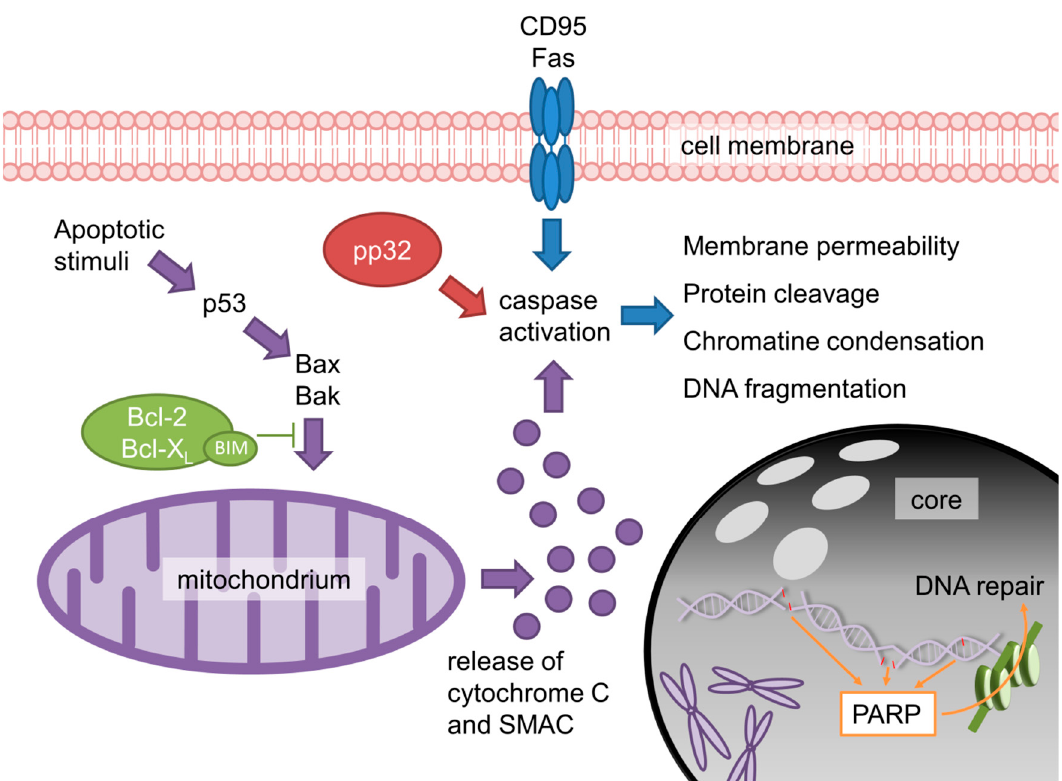
Figure 4. Pro-apoptotic and anti-apoptotic pathways in cancerogenesis. Both extracellular and intracellular pathways lead to caspase activation and thus induce cell death. Distinct factors such as pp32/PHAPI sensitize cells to apoptotic stimuli.